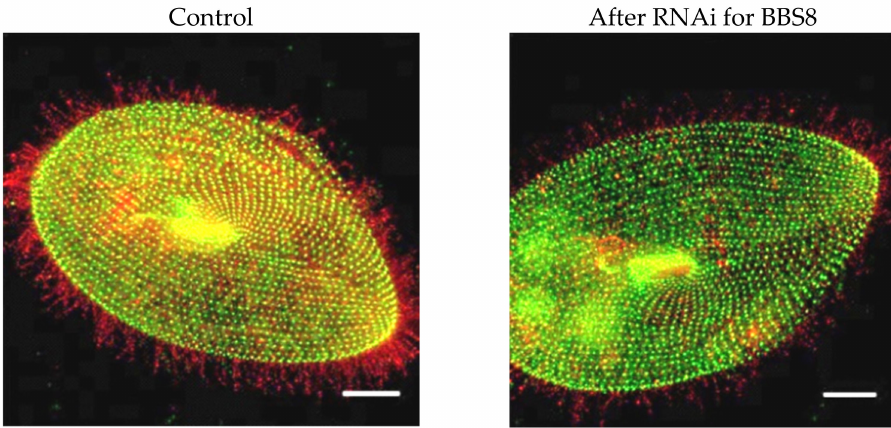
Figure 7. Immunofluorescence of FLAG-Xnt, an interacting partner of PKD2. Only the merged images are shown here. FLAG control is a cell microinjected with FLAG-pPXV vector and fed RNAi empty vector bacteria (not shown). FLAG-Xnt controls are cells expressing FLAG-Xnt and fed bacteria with an RNAi empty vector. “BBS8”cells are expressing FLAG-Xnt and are also depleted of BBS8 mRNA by RNAi. Cells were immunostained with anti-FLAG (red) and basal body (green for Tetrahymena centrin) antibodies. (Valentine